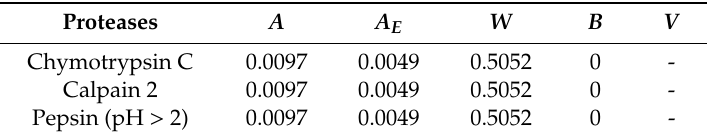
Table 6. The values of parameters describing the predicted e ffi ciency of release of bioactive antithrombotic fragment from Halophila stipulacea -RubisCO by